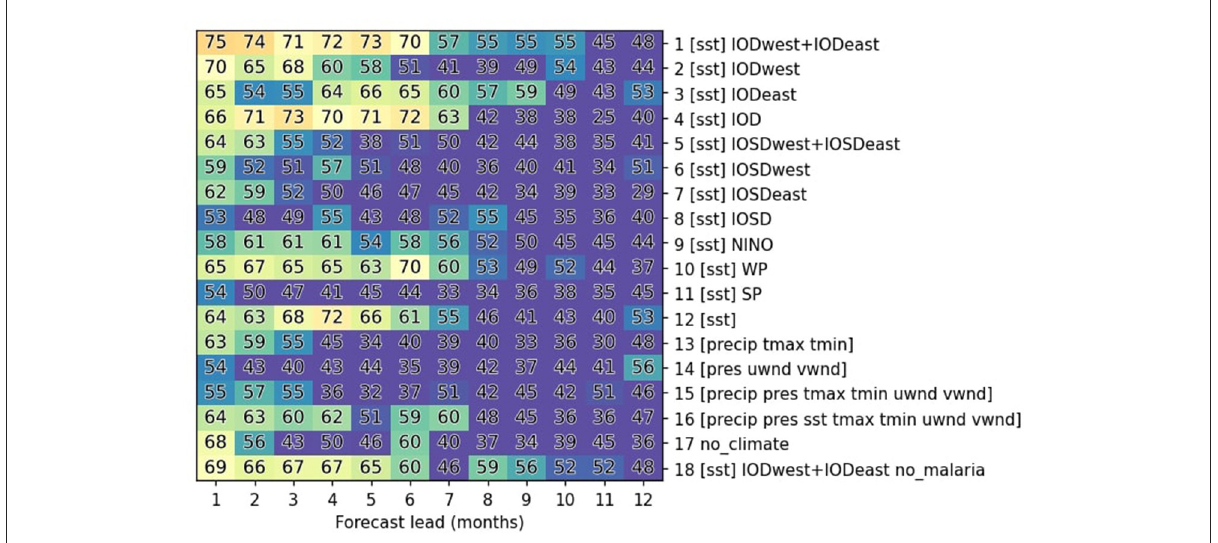
FIGURE5 Summary of malaria prediction skills for various experimental setups. Malaria prediction accuracy is averaged over the months of December-April when malaria incidence is high (Figure 1). It is reported for a multi-model voting ensemble composed of the three best classifiers for each experimental setting (y-axis) and prediction lead (x-axis). Accuracy is indicated with numbers as the percentage of successful predictions and illustrated with colors with warmer colors indicate higher accuracies. Accuracies below 50 % are shown in